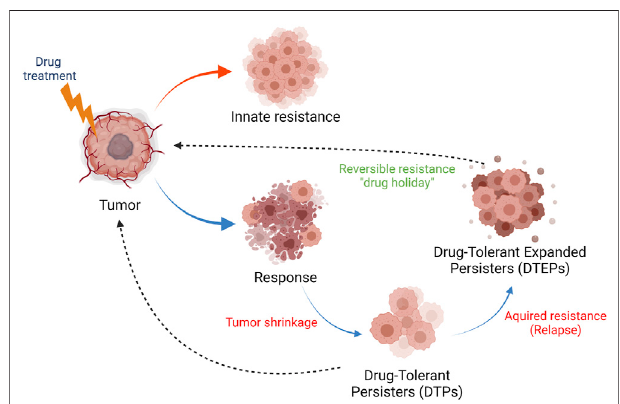
FIGURE 1 | Innate and acquired drug resistance in cancer. Tumors can display innate resistance to therapy (red arrow), the causes and origins of which are not completely understood. Tumors can also develop acquired therapy resistance (blue arrows). Upon exposure to therapy and response,afractionoftumorcellssurvivetheinitiallethaldrugexposure – drug- tolerant persister (DTPs) cells. This dormant state, which can be reversible, contributestotherapyrelapseortheestablishmentofdrug-tolerantexpanded persister cells (DTEPs) that harbor many genetic and epigenetic changes developed in order to adapt to the drug exposure. It should be noted that rare pre-existingresistancemutationshavealso been foundinhumantumors.The DTEP state can, following a “ drug holiday, ” return to a drug-responsive tumor state (black, dotted arrow), a phenomenon reported in tissue culture and in patients. Many mutational, non-reversible, resistance mechanisms have also been described in tumors from patients that have relapsed on